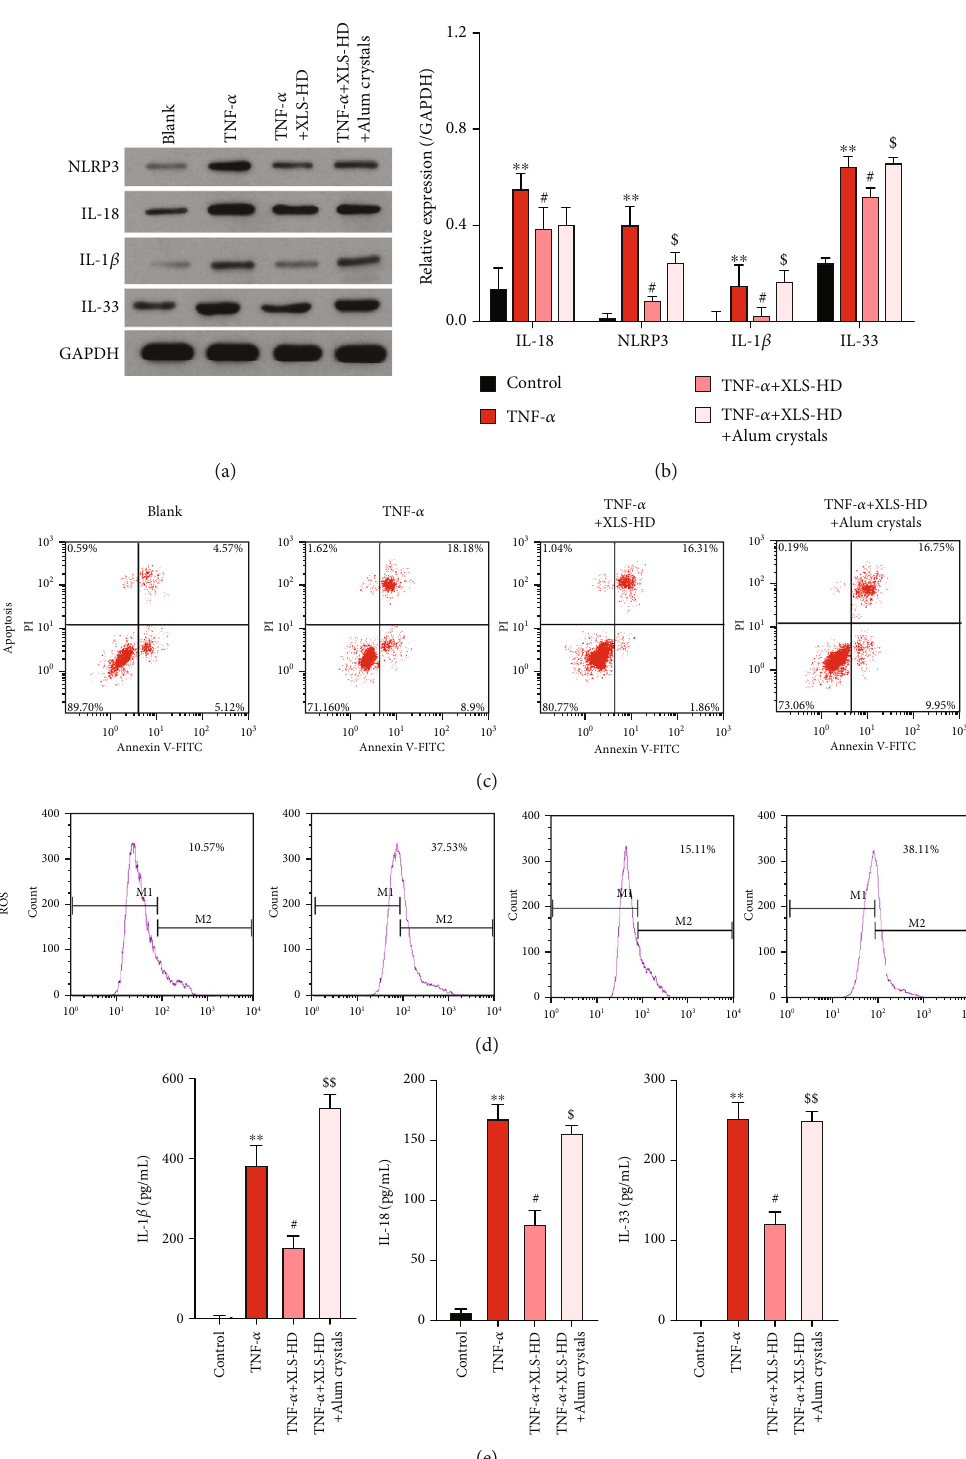
Figure 5: Xi Lei San suppressed apoptosis and reduced ROS levels and in fl ammation in TNF- α -stimulated CACO2 cells by inhibiting NLRP3 in fl ammasomes. TNF- α -induced CACO2 cells were treated with Xi Lei San and alum crystals. (a) A western blotting analysis was performed to examine the levels of NLRP3, IL-18, IL-33, and IL-1 β expression in the CACO2 cells following their treatment with Xi Lei San and alum crystals. (b) A quantitative analysis of western blotting results was performed. (c) A fl ow cytometry analysis showed the apoptosis rate of CACO2 cells after treatment. (d) ROS production was determined by fl ow cytometry. (e) ELISA assay was used to detect the concentrations of IL-1 β , IL-18, and IL-33 in the treated CACO2 cells. ∗∗ P < 0 : 01 vs. the control group; # P < 0 : 05 vs. the TNF- α group; $ P < 0 : 05 and $$ P < 0 : 01 vs. the TNF- α +Xi Lei San